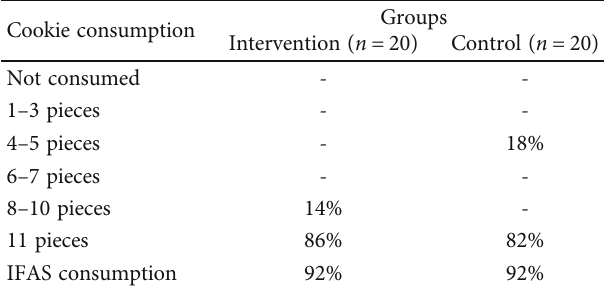
Table 5: Compliance rate of IFAS and cookie consumption in both groups